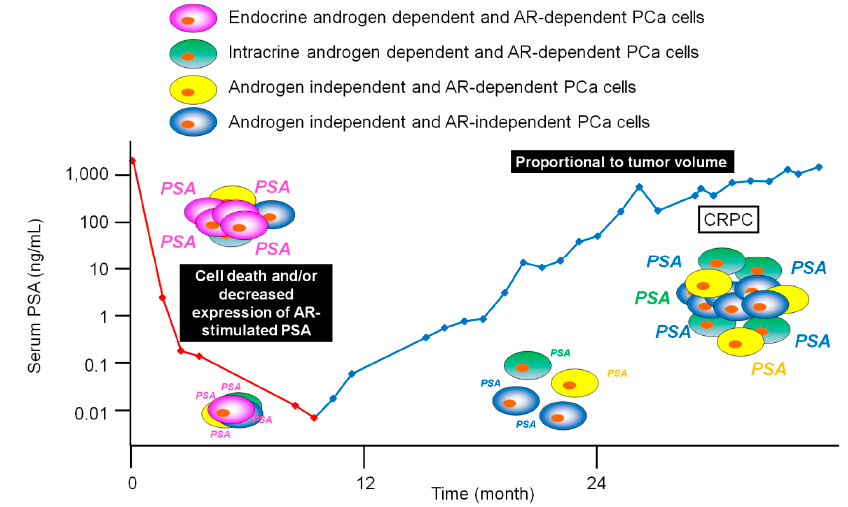
Figure 1. Serum PSA kinetics after primary ADT. Decreases in PSA levels following primary ADT are due to tumor cell death and/or simply decreased expression of AR-stimulated PSA in response to the absence of androgen. Figure 1 refers to [23]. AR: androgen receptor; PCa: prostate cancer; CRPC: castration-resistant prostate cancer; PSA: prostate-specific antigen; ADT: androgen-deprivation therapy.